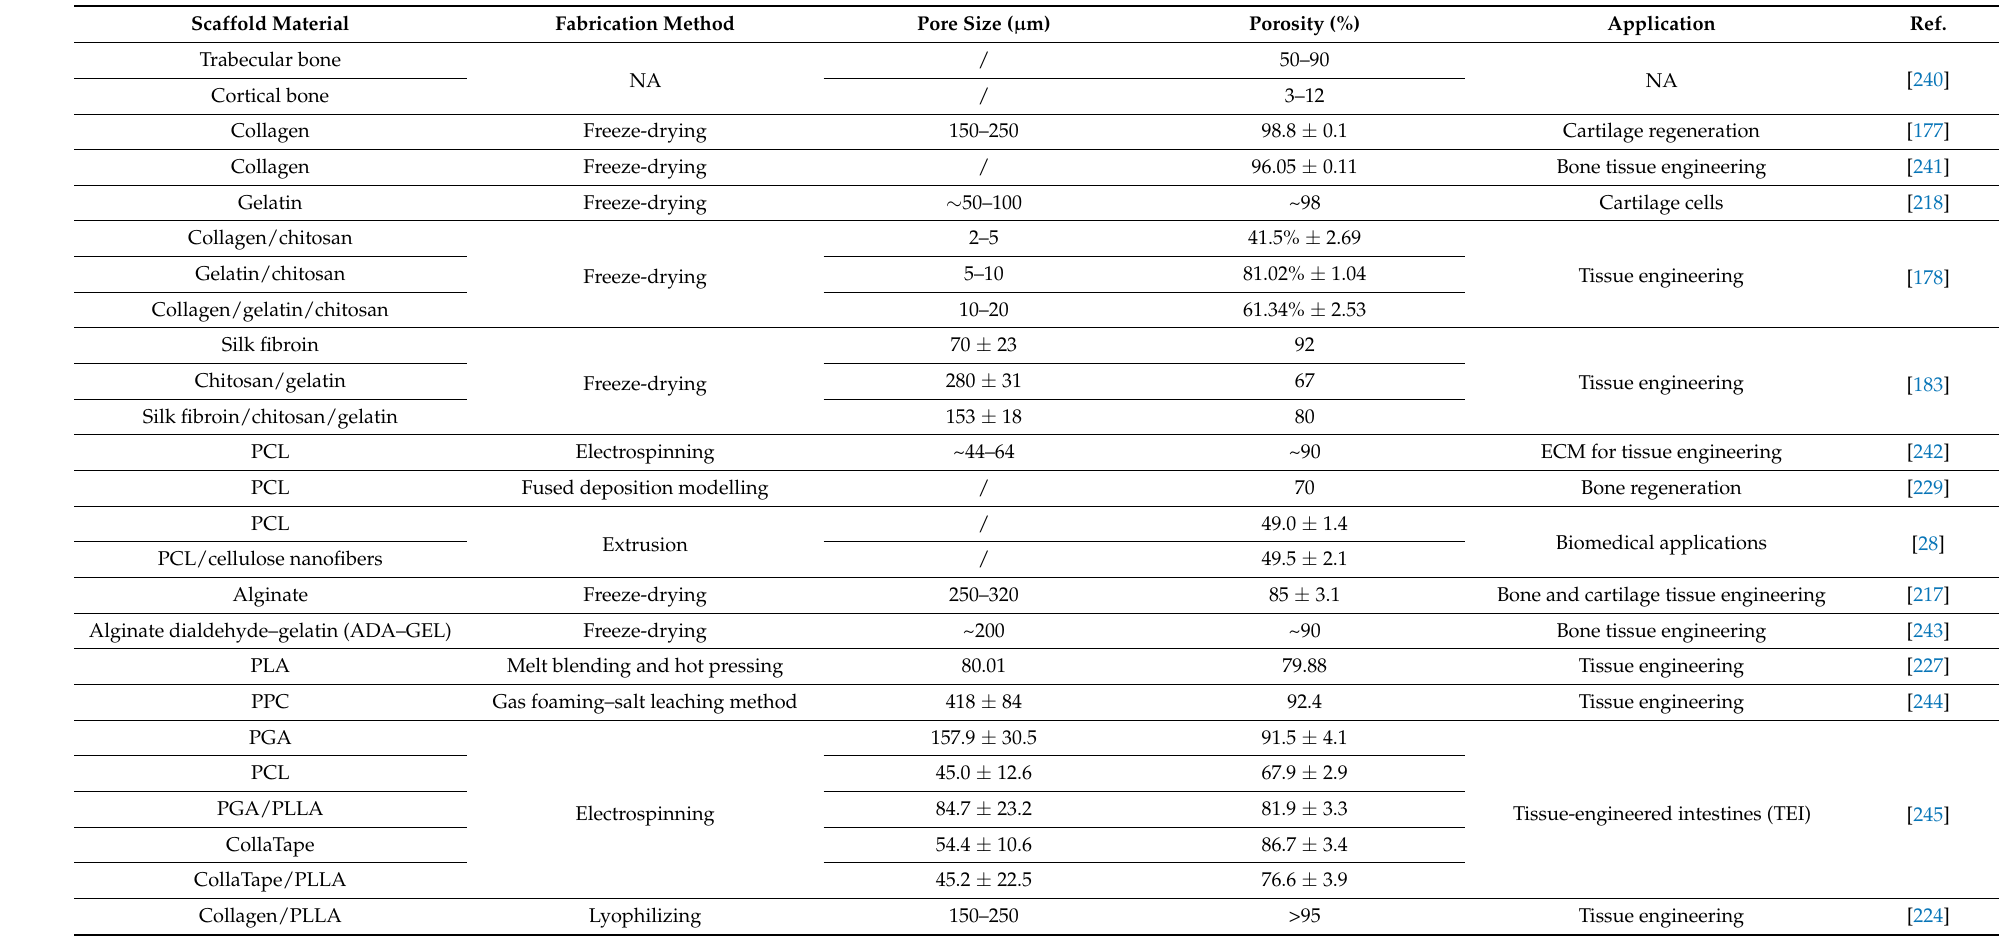
Table 5. The porosity and pore size of polymer